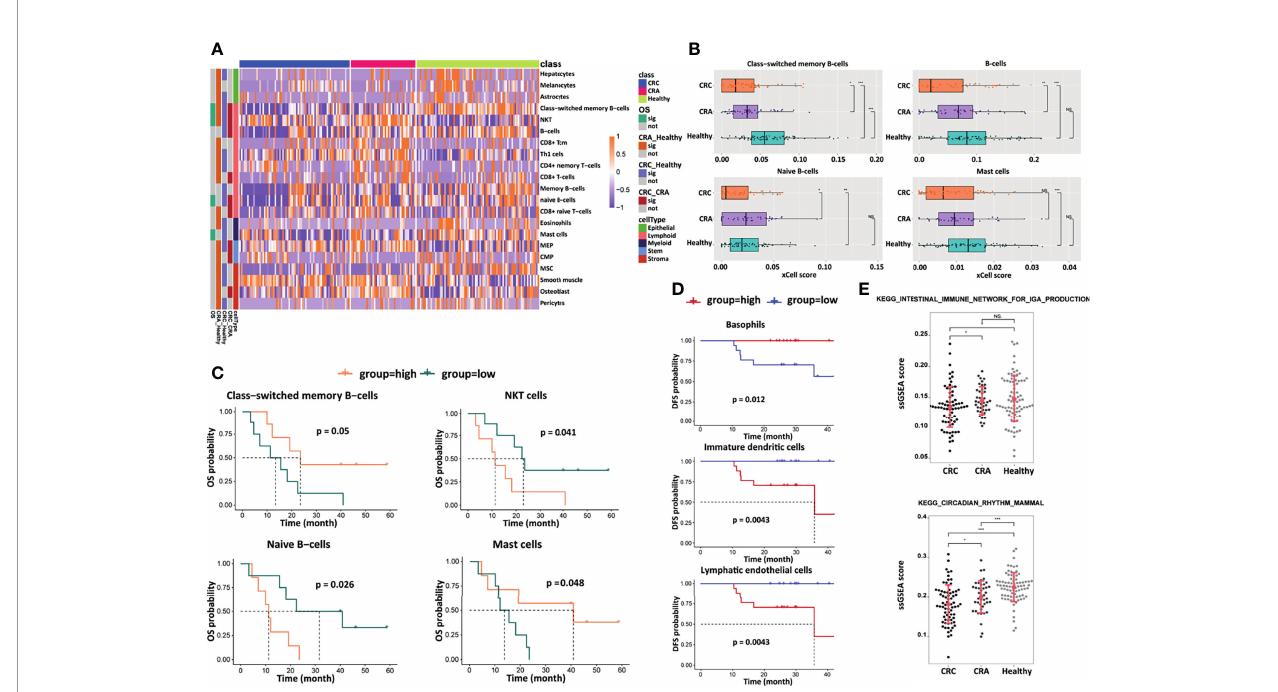
FIGURE 5 | Analyses of cell components, survival, and signaling pathways. (A) Heatmap of unsupervised hierarchical clustering of the 21 cell types in different groups. (B) Box plots of selected cell-type abundance between CRC, CRA, and healthy groups. Prognostic signi fi cance of selected cell types by (C) OS and (D) DFS. (E) ssGSEA score and statistical signi fi cance for selected KEGG pathways differing between CRC, CRA, and healthy groups. ***p < 0.001; **p < 0.01; *p < 0.05; NS, not signi fi